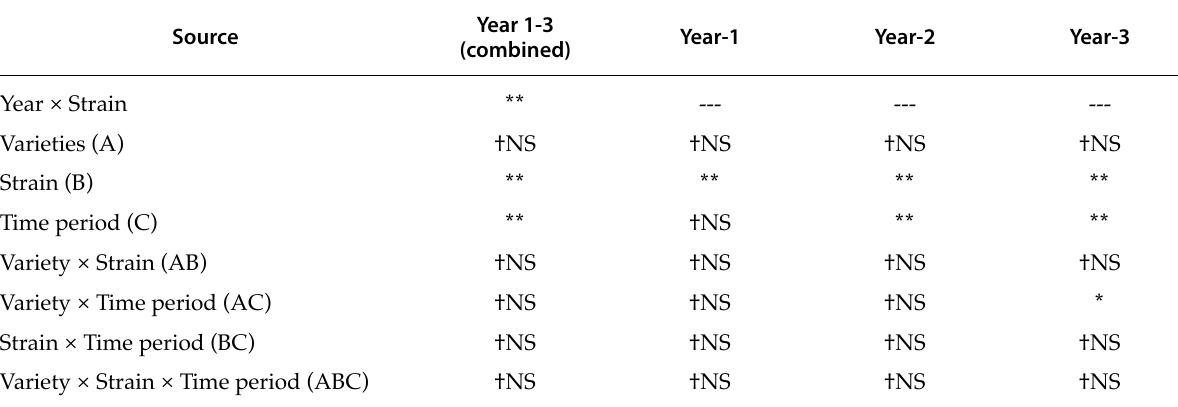
Table 4. Analysis of variance table for the bacterial strain biocontrol activity against Colletotrichum falcatum on plants of two sugarcane varieties in “stalk inoculation”